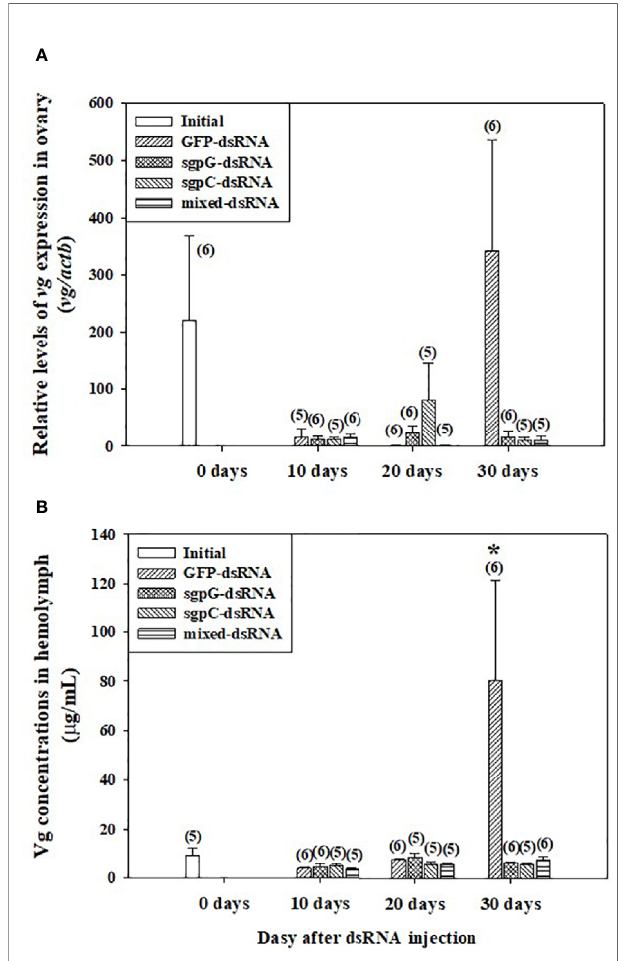
FIGURE 2 | Levels of (A) vg mRNA in ovary and (B) Vg in hemolymph following a single injection of GFP-dsRNA, sgpG-dsRNA, sgpC-dsRNA, mixed-dsRNA, or no injection (initial). Results are expressed as the mean ± SEM. The asterisk indicates signi fi cant difference ( P < 0.05) from the initial group. Values in parentheses indicate numbers of shrimp analyzed in each group. Abbreviations are as follows. Vg, vitellogenin; actb, beta-actin. The content of each treatment group is indicated in the legend box that appears above each bar